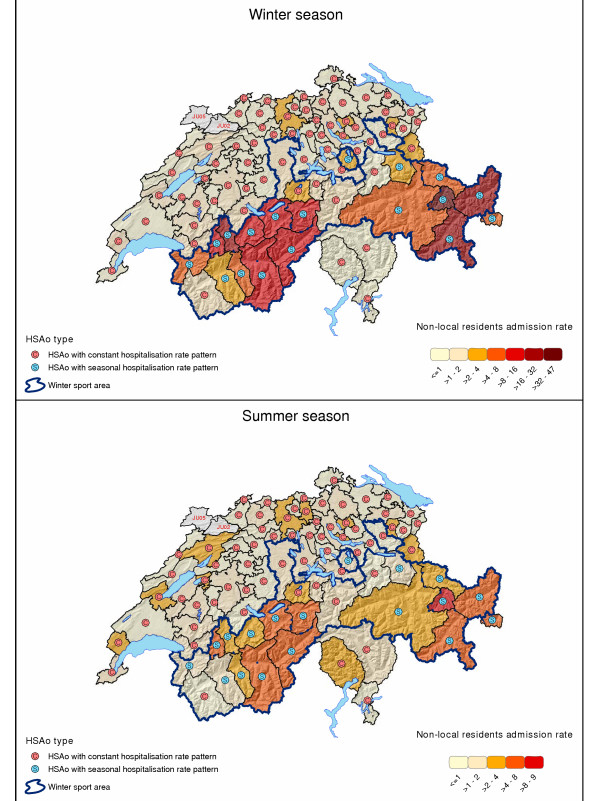
Nonlocal residents admission rates in winter and summer. Average monthly admission rates for nl-res in winter (December, January, February and March) and summer (June, July, August, September) month.